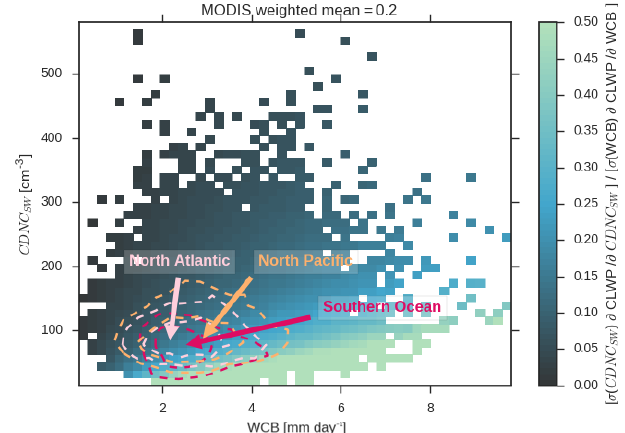
Figure 16. The relative contribution to CLWP of perturbations in CDNC SW and perturbations in WCB as estimated using Eq. (1) and the standard deviation of each predictor over the historical record. The regression model was trained using MODIS-retrieved CDNC SW (the same plot is shown for MERRA2-inferred CDNC SW in Fig. S13). The partial derivative of Eq. (1) is taken with respect to each predictor and scaled by the standard deviation of that predic- tor. The ratio of the partial derivative scaled by standard deviations in each of the predictors is shown using colors. The joint probabil- ity distribution of cyclones during the observational record for dif- ferent ocean regions are roughly indicated using dashed lines. The joint probability distribution of all observations is used to calculate the weighted mean of the fractional contribution of perturbations in CDNC SW and WCB over the range of WCB and CDNC SW in the observational